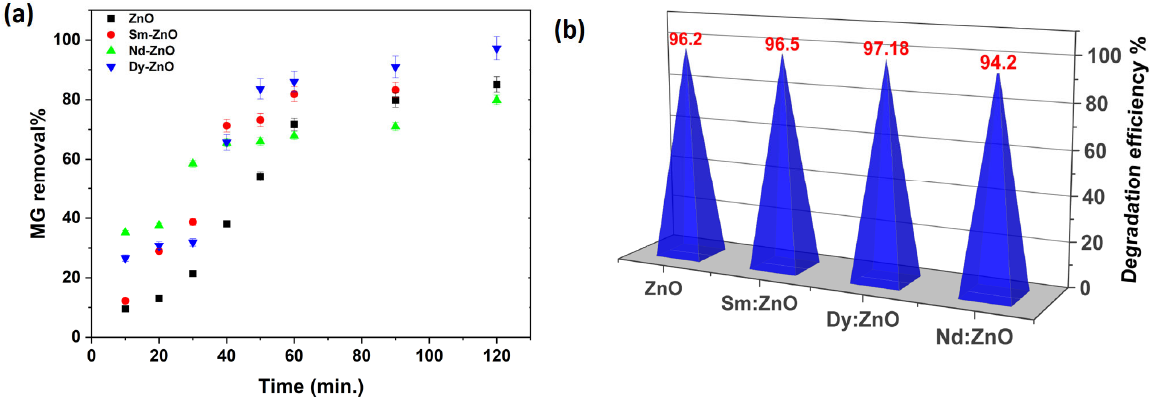
Figure 13. Degradation efficiency against ( a ) MG dye achieved in a 120 min experiment; ( b ) Crystal violet dye. Table 3. Comparison of previously reported work on various pollutants ʹ degradation using ZnO ‐ based photo catalysts.